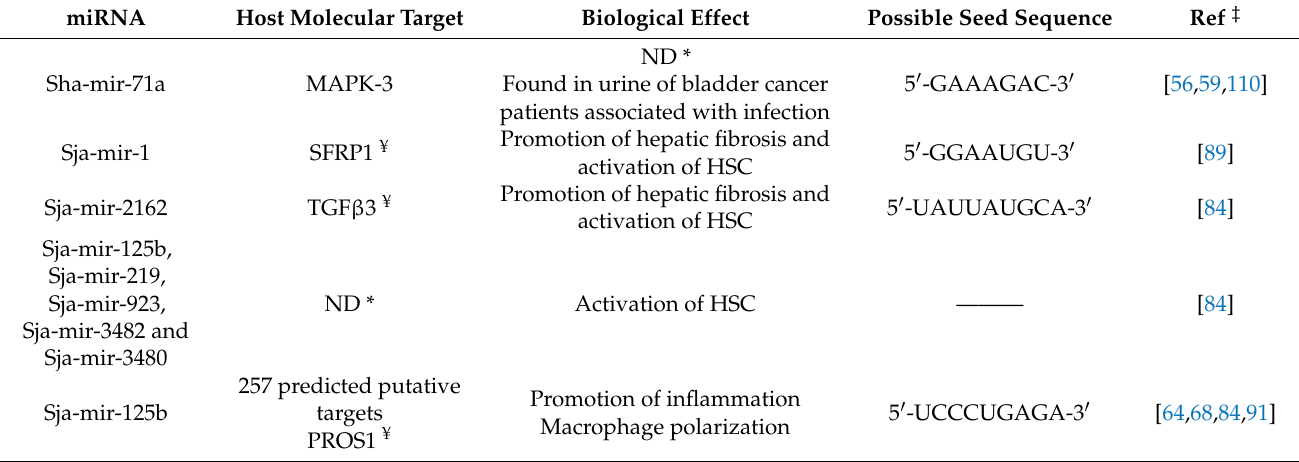
Table 2. Parasitic miRNAs possibly involved in cancer